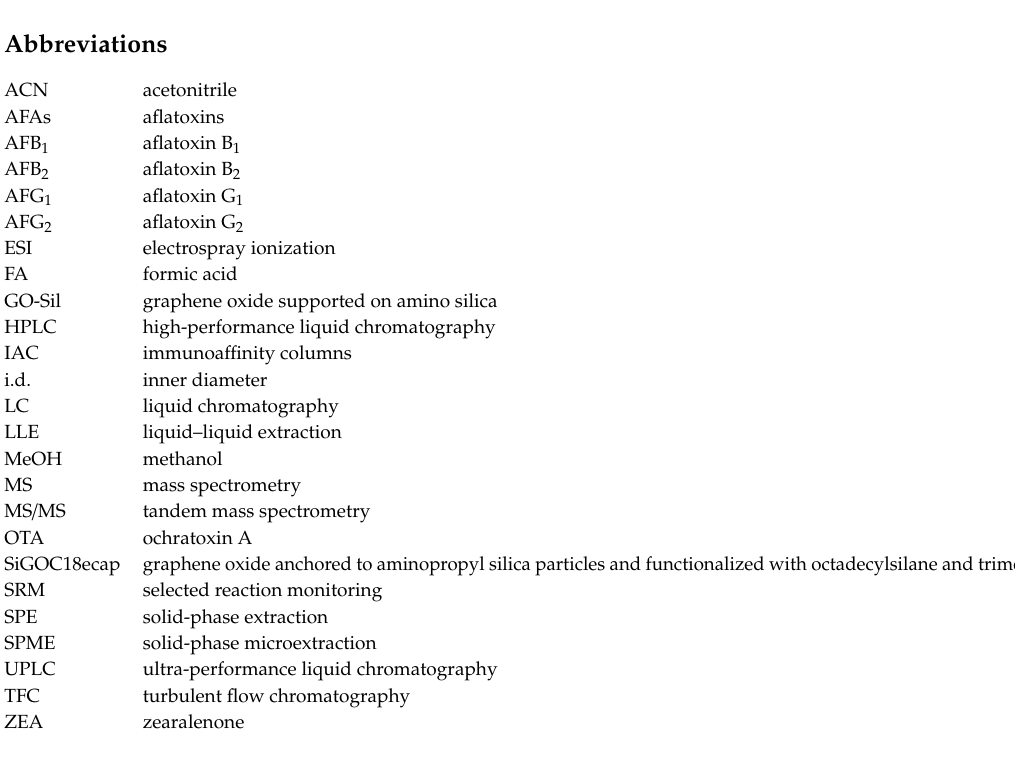
(A) almond liquor, (B) co ff ee liquor, and (C) standard solution. All of them were spiked at a concentration of at 15 µ g L − 1 ; Figure S7: Typical microcolumn hardware used as an extraction device in both systems; Table S1: Analytes’ precursor and product-ion and its main detection parameters utilized in the selected reaction monitoring MS